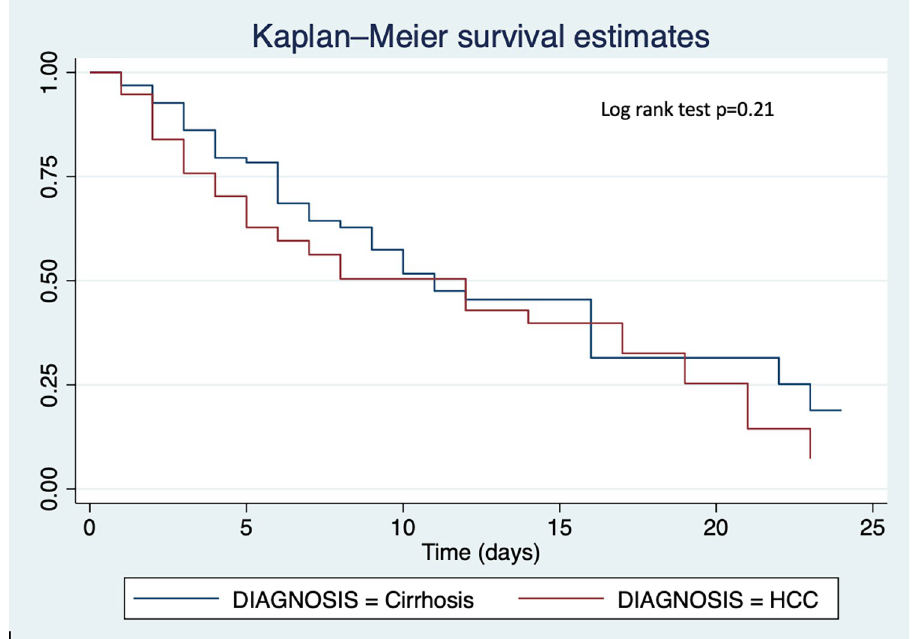
Fig 4. Kaplan-Meier survival curves comparing in-patient survival probabilities between liver cirrhosis patients and HCC patients.